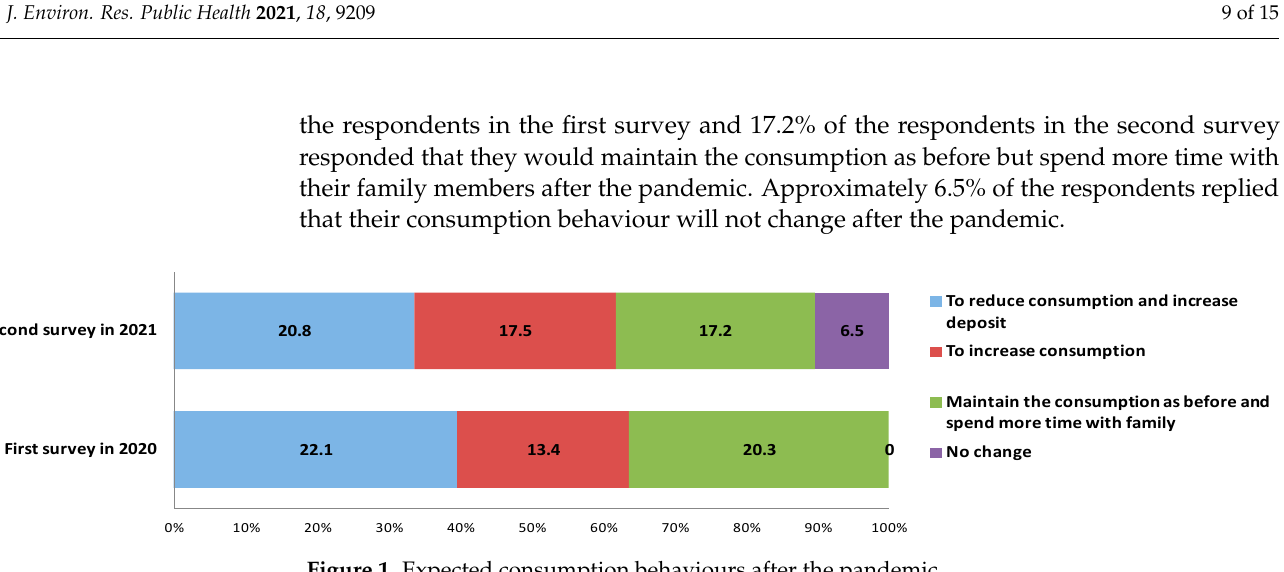
Figure 1. Expected consumption behaviours after the pandemic.